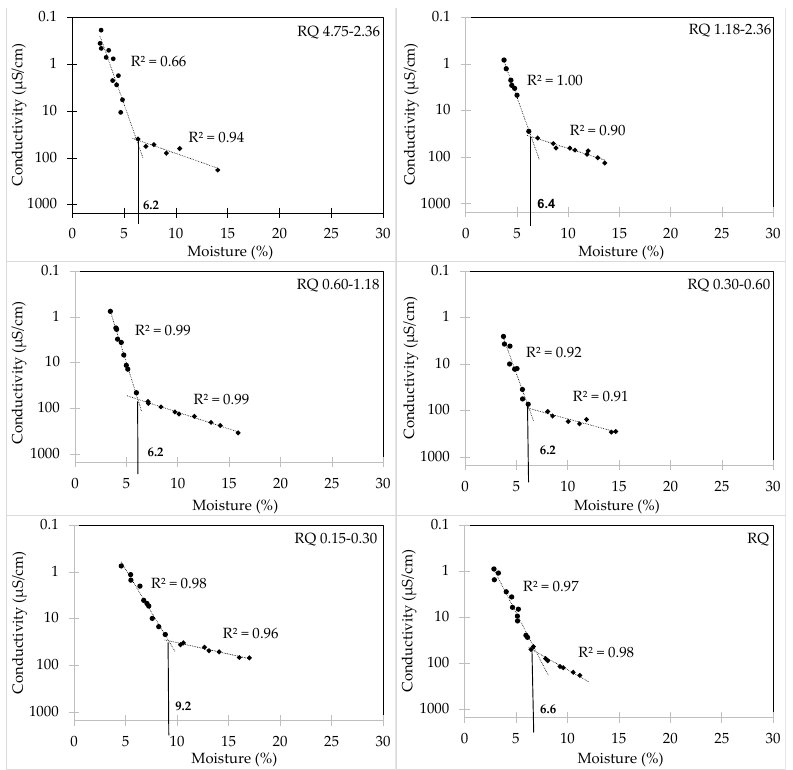
Figure 4. Moisture contents versus conductivity plots, including the SSD state of RQ samples. Appl. Sci. 2022 , 12 , x FOR PEER REVIEW